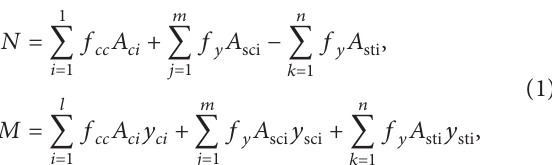
Figure 10: Influence of steel tube thickness t on the resistance correlation curves. (a) Forward loading. (b) Forward loading